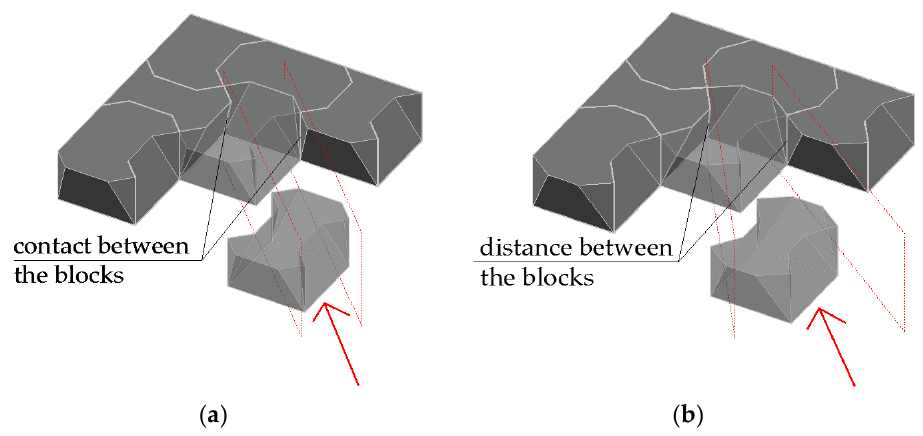
Figure 26. Sliding the components into place in a both sides smooth vault if the planes containing the side faces of the components are: ( a ) parallel; ( b ) intersecting.